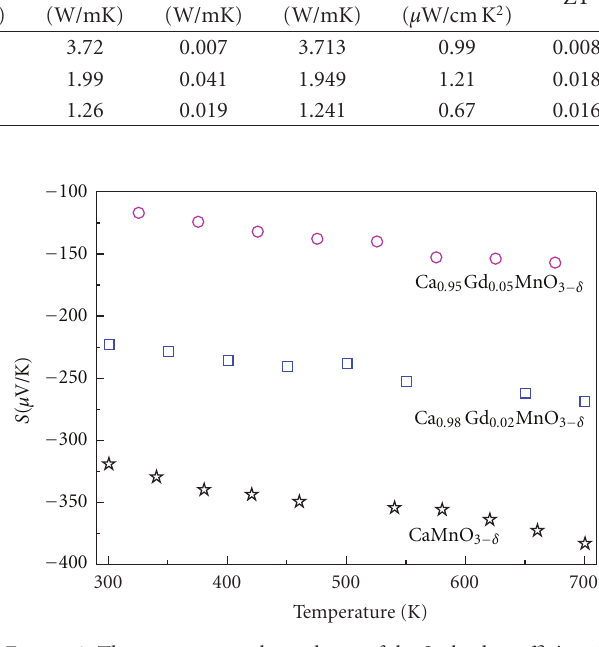
Table 2: Room temperature characterization and properties of the Ca 1 − x Gd x MnO 3 − δ (0.00, 0.02, and 0.05). Samples